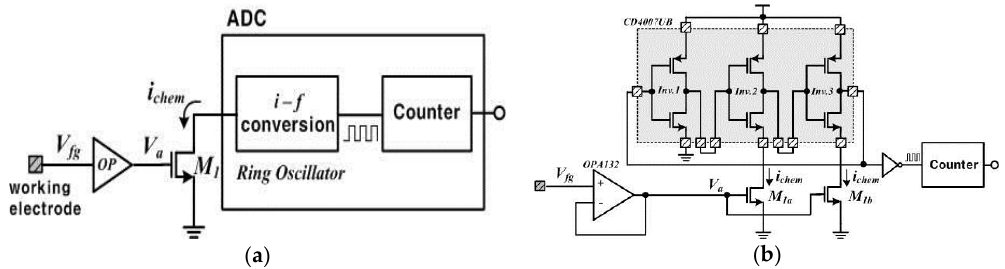
Figure 2. ( a ) Simplified description of the readout circuits; ( b ) detailed description of the readout